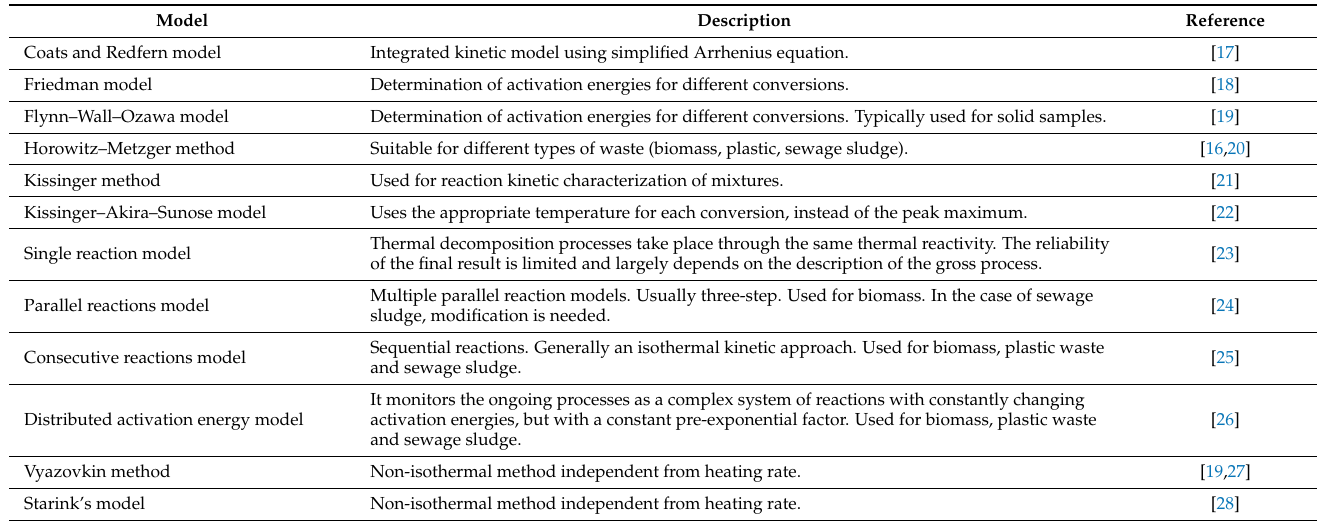
Table 1. Principal reaction kinetic approaches used for waste polymer pyrolysis.